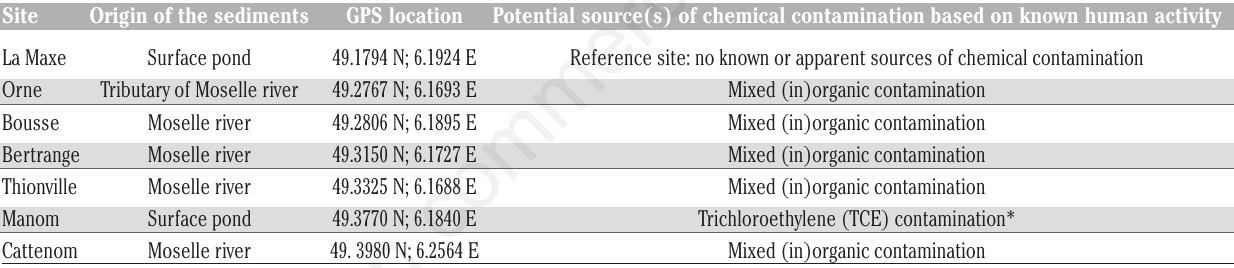
Table 1. Characteristics of Moselle river watershed sediment sampling sites in terms of their emplacement and potential for contami- nation.